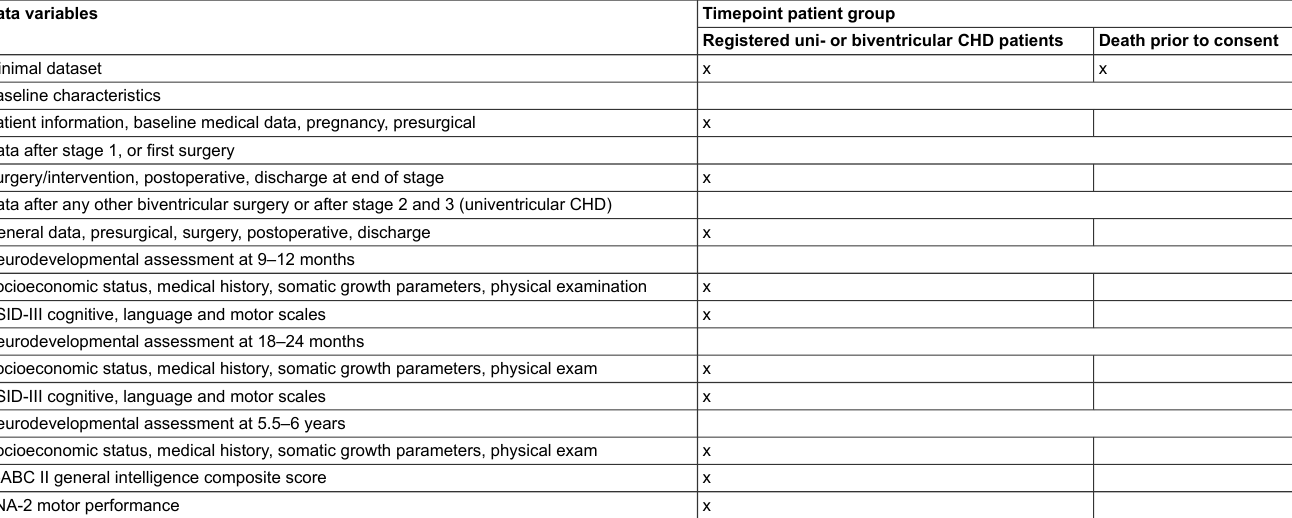
Table 2: ORCHID data collection during follow